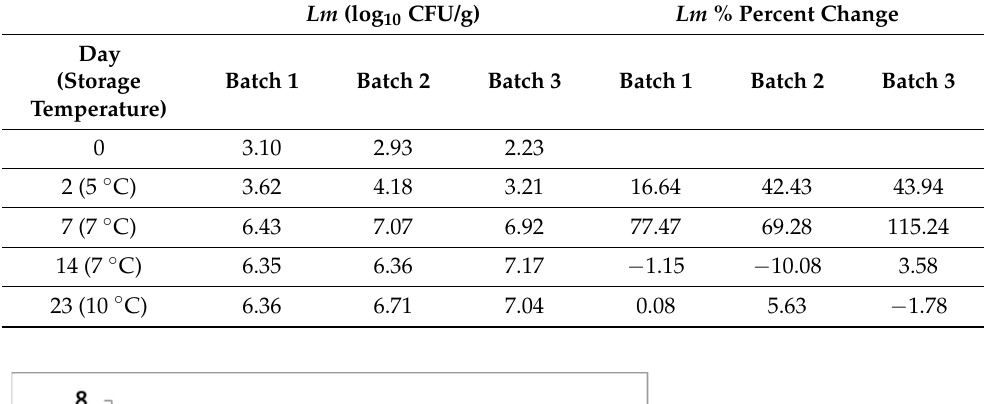
Table 3. Lm concentration (log 10 CFU/g) in the 3 contaminated batches of ready-to-eat food (cheese) during storage at 5 ◦ C, 7 ◦ C, and 10 ◦ C in the studied period (“Day 0” = day of inoculation, “Day End” = end of shelf life, that is, the 23rd day upon receipt of the batches at the 2nd day of production. The shelf life of the product was 25 days).